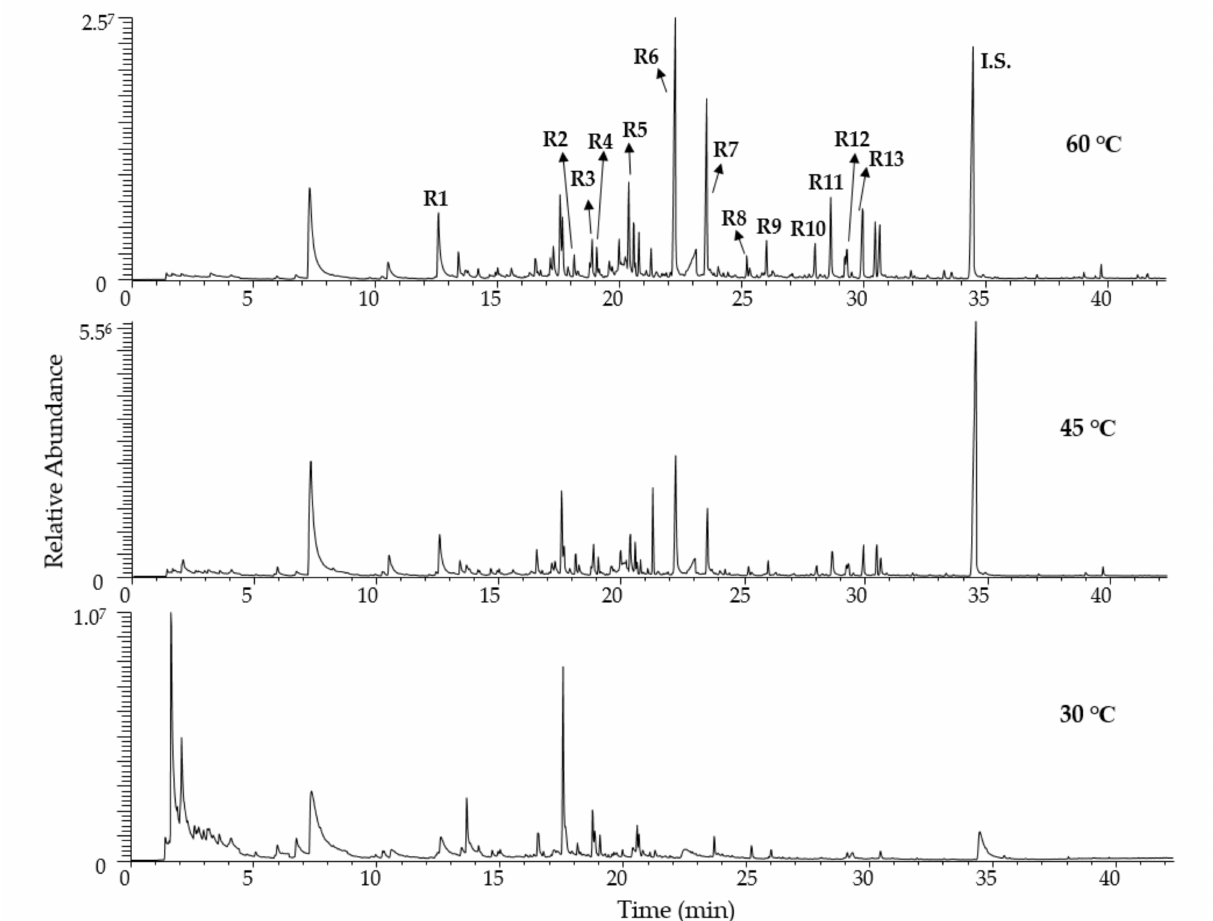
Figure 1. Chromatograms of the same sample at different temperatures (30, 45, and 60 ◦ C). The equilibration time, also known as “thermostating time”, showed an uncommon high value at 30 min. Figure 2 presents the desirability surface area of all